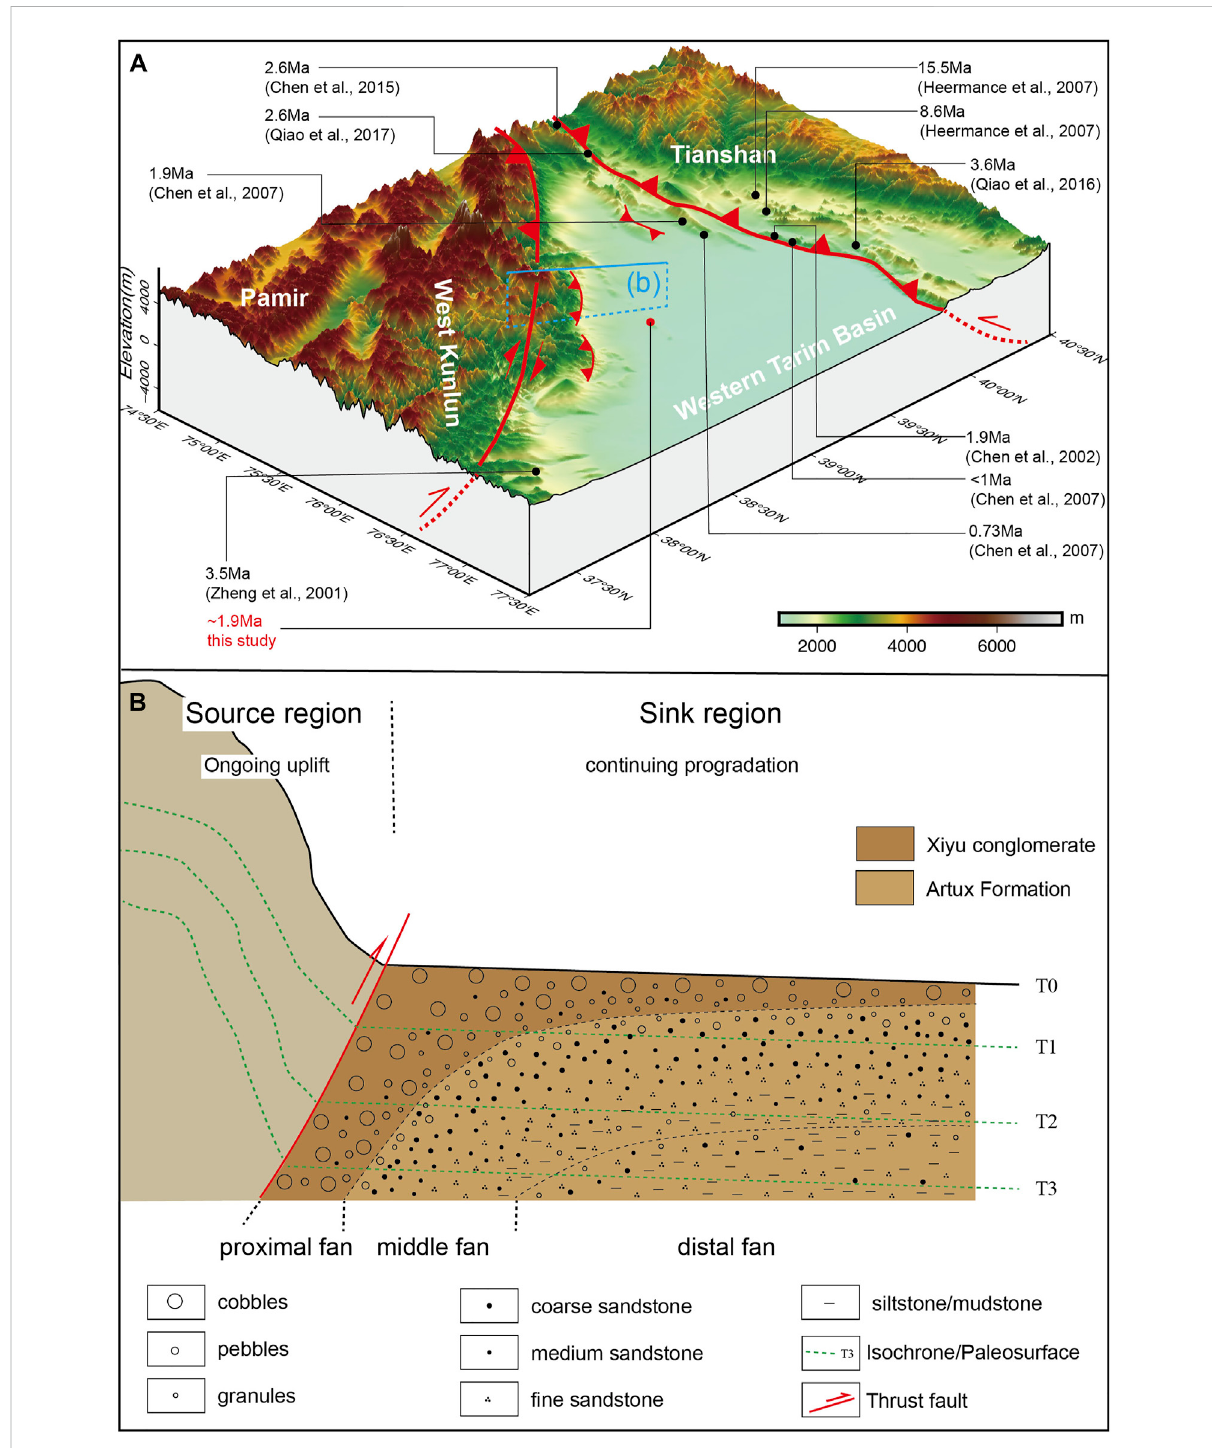
FIGURE 12 (A) , Basal ages of the Xiyu Formation in the edge of western Tarim Basin. (B) , Conceptual model of the progradational alluvial fan of upward coarsening deposits in the piedmont of an ongoing uplift